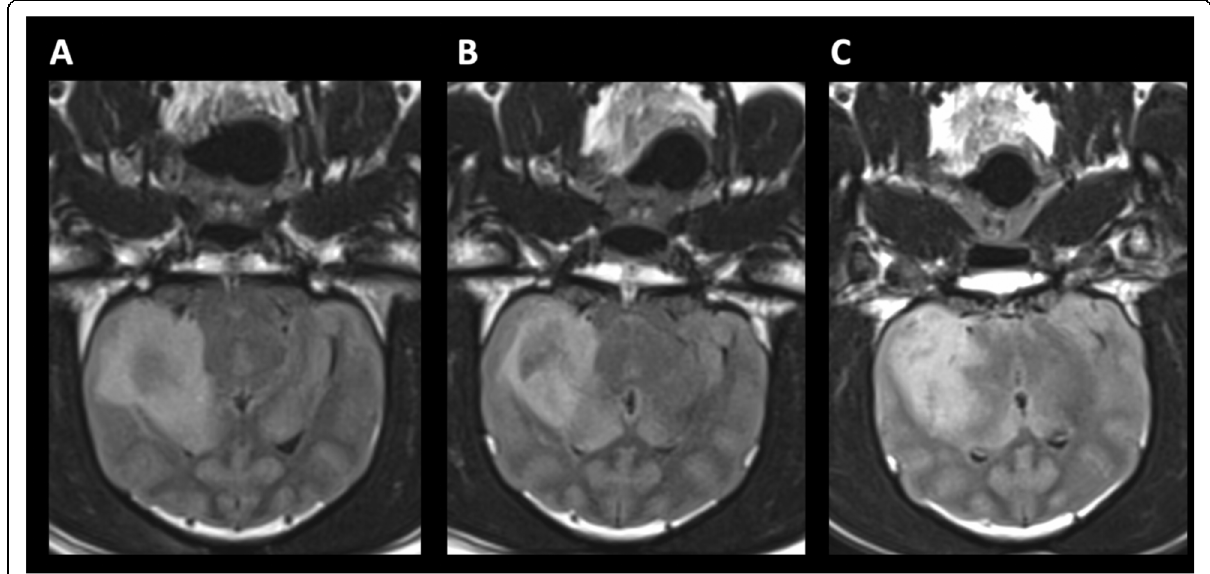
Fig. 8 P4 T2 FLAIR at a 1 month pre-treatment, b 1 month post-treatment and c 6 months